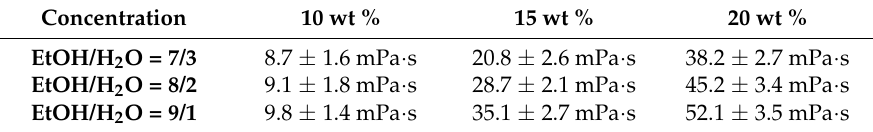
Table 1. The viscosity value of electrospun zein nanomaterials from ethanol aqueous solutions with ethanol/water ratios of 7/3, 8/2 and 9/1 ( v/v ) according to polymer concentrations of 10, 15 and 20 wt %, respectively (Tip-to-collector distance (TCD) = 15 cm and applied voltage = 15 kV) at 25 ◦ C.